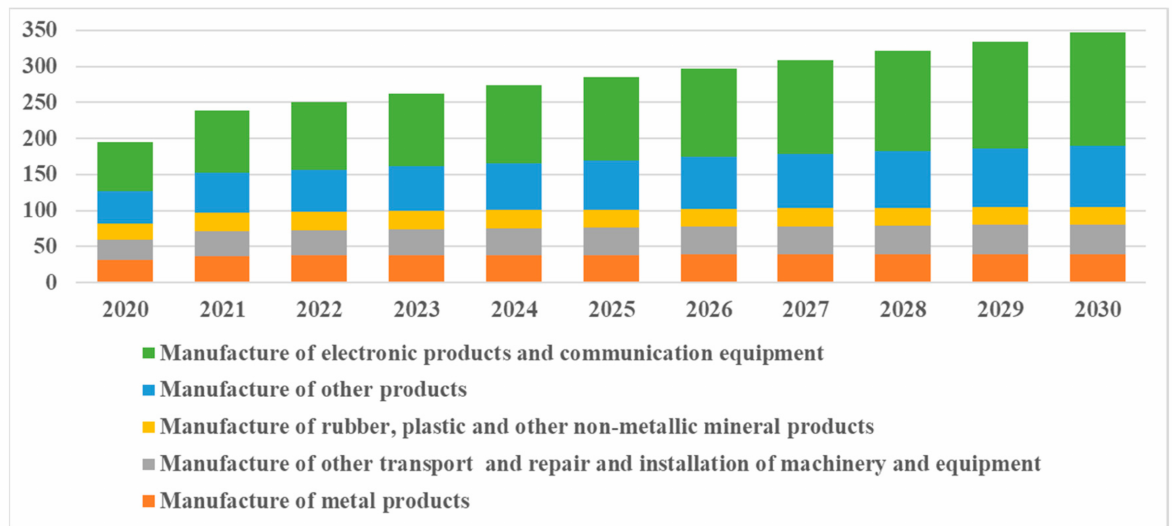
Figure 14. Real value added till 2030, million EUR (own estimation).